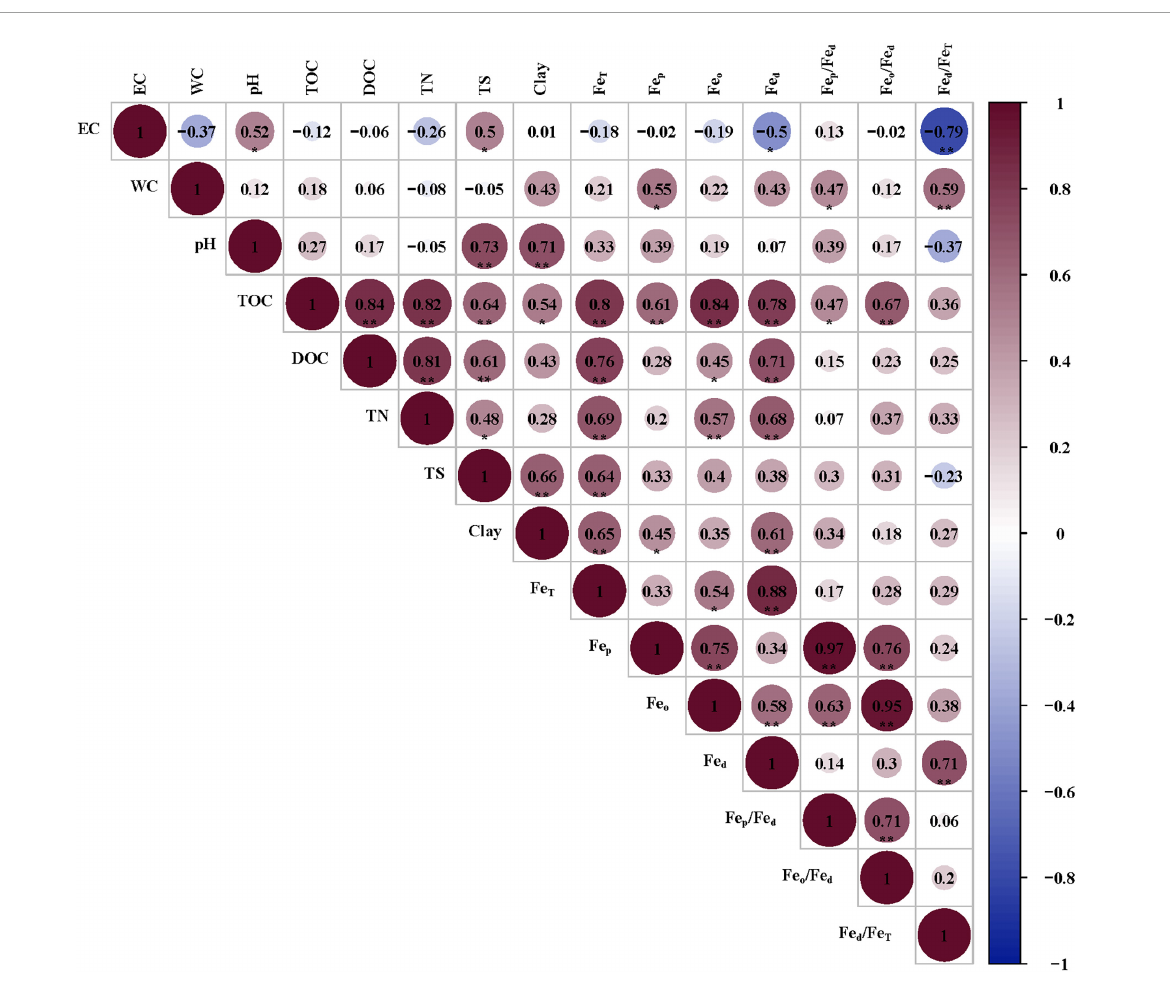
FIGURE5 Correlations between iron and factors in soils of different communities. EC, WC, TOC, DOC, TN, and TS represent electrical conductivity, water content, total organic carbon, dissolved organic carbon, total nitrogen, total sulfur, respectively. * and ** represent a significant difference at the level of 0.05 and 0.01,